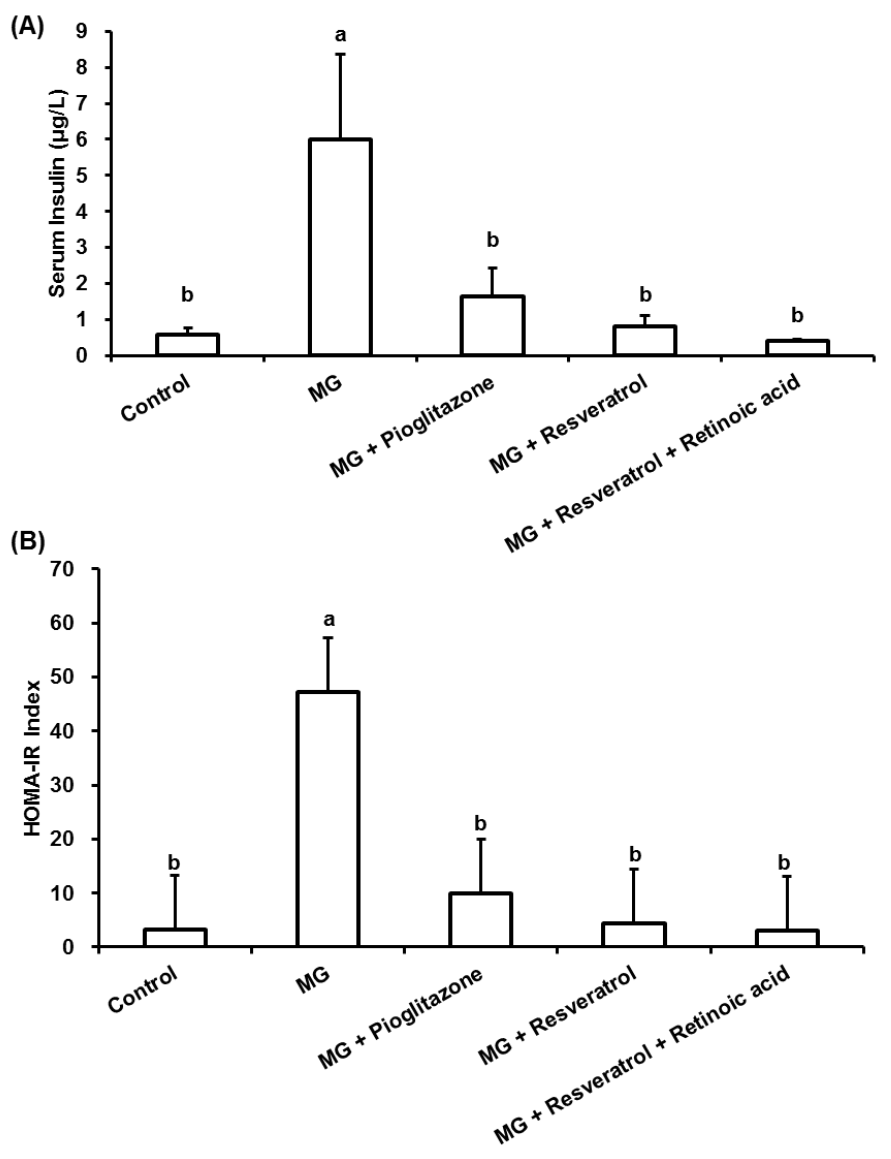
Figure 2. The anti-diabetic effects of resveratrol on ( A ) serum insulin and ( B ) homeostasis model assessment-insulin resistance (HOMA-IR) in methylglyoxal-treated Balb/C mice. The data shown represent the mean ± SD ( n = 6). (a,b) indicate a statistically-significant difference at p <